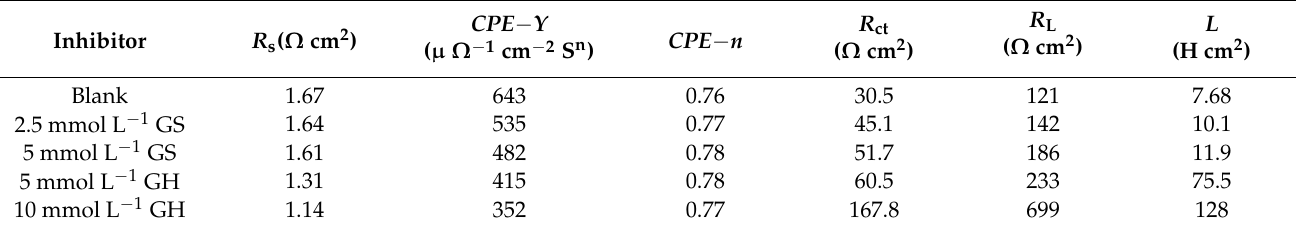
Figure 3. EEC to fit the EIS data for the electrodes in 0.5 mol L − 1 H 2 SO 4 solution without and with various amounts of glucosamine salts. Table 3. EIS fitting results for the electrodes in 0.5 mol L − 1 H 2 SO 4 solution without and with various amounts of glucosamine salts.